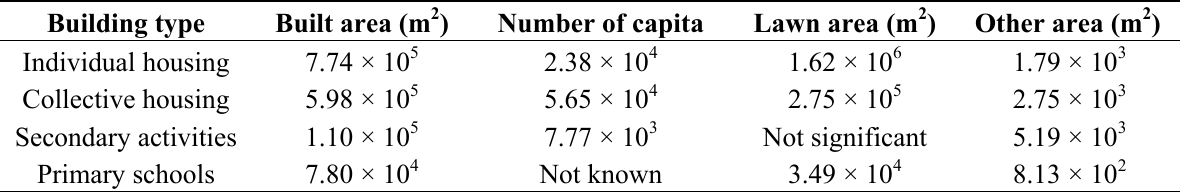
Table 5. Values of the variables needed to calculate